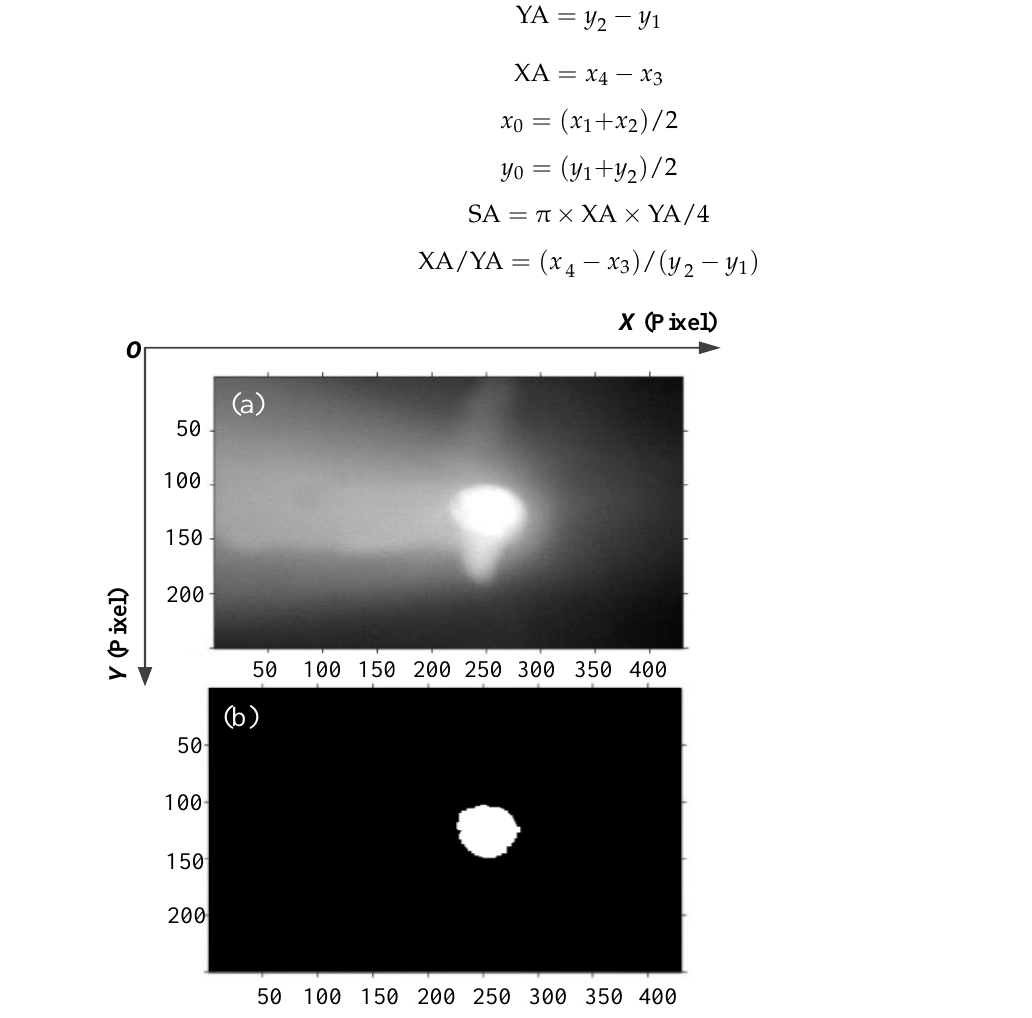
. Figure 4. The geometric dimensions of the keyhole size.